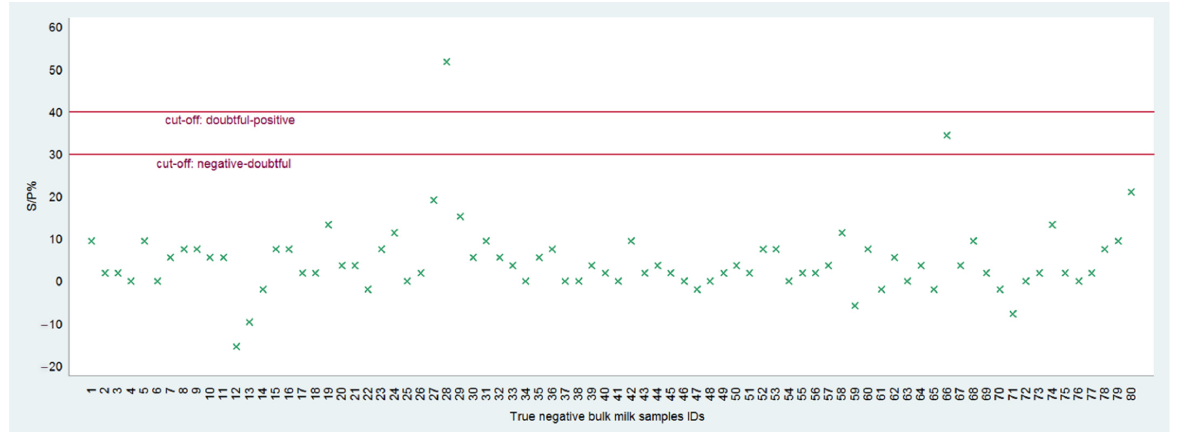
Figure 4. Results obtained from the negative reference bulk milk samples tested with the gE indirect ELISA. Table 6. Dichotomised results of gE indirect ELISA performed on the reference samples panel: cross-tabulation according to the IBR status of the reference samples.